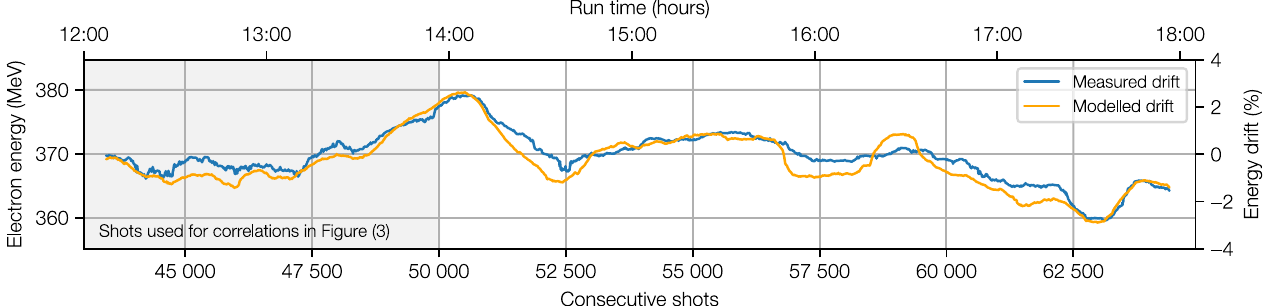
FIG. 4. To model the measured electron energy drift (blue), we used Eq. (1), the correlations presented in Fig. 3, and the drift of the measured laser energy, laser focus shift, and laser direction. As before, we calculated the drift as the 6-min rolling average (360 shots) of the single-event data. Only four noninvasively measured laser parameters are sufficient to predict (orange) the evolution of the electron energy with subpercent accuracy. The modeled electron energy is accurate for a 6-h (22 000 shots) time span, which significantly exceeds the 2-h time window (7000 shots) we used to correlate the laser and electron data.